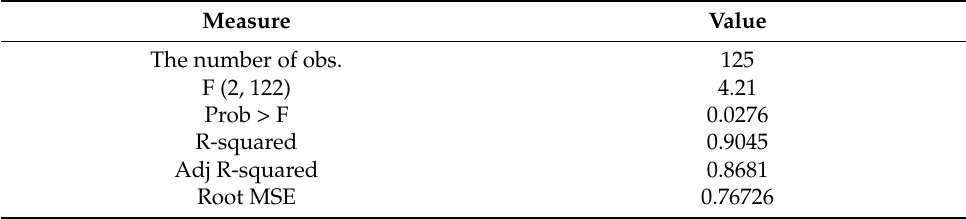
Table 4. Statistical analysis after onset of COVID-19 pandemic. Measure Value The number of